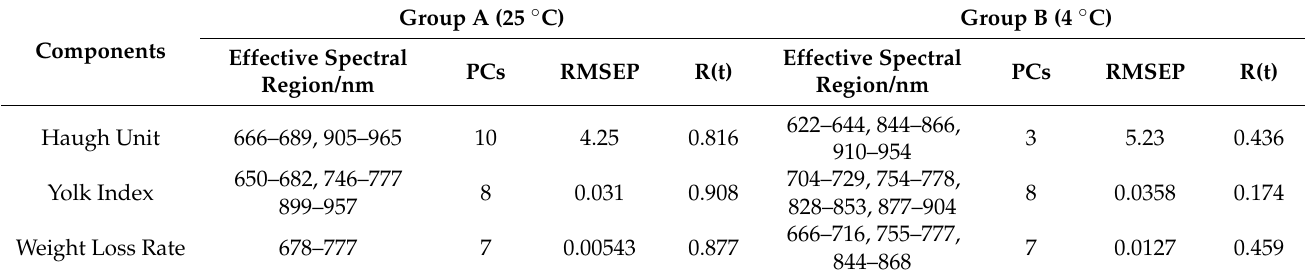
Table 5. Performance of optimal Si-PLS models for egg physics indexes prediction.